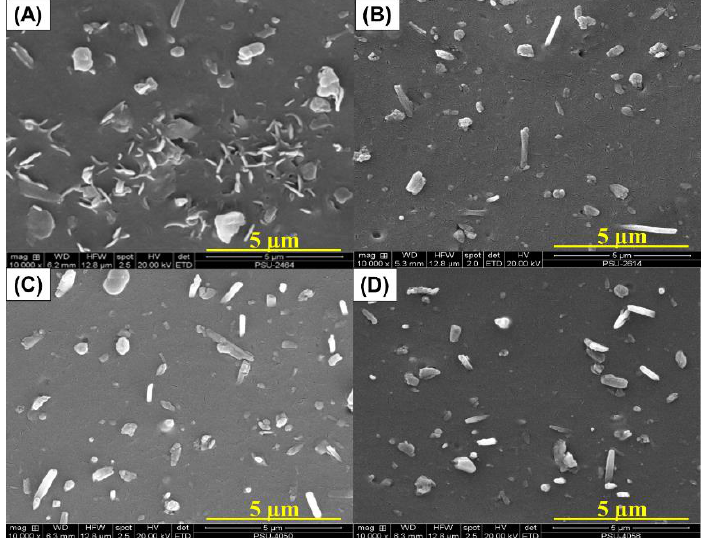
Figure 11. SEM images of tensile fractured surfaces of NR / HNT composites in the presence of MNR / MPS as a dual compatibilizer: Reference ( A ), MPS 0 phr ( B ), MPS 0.5 phr ( C ), and MPS 1.5 phr ( D ), all at 10,000 × magnification.